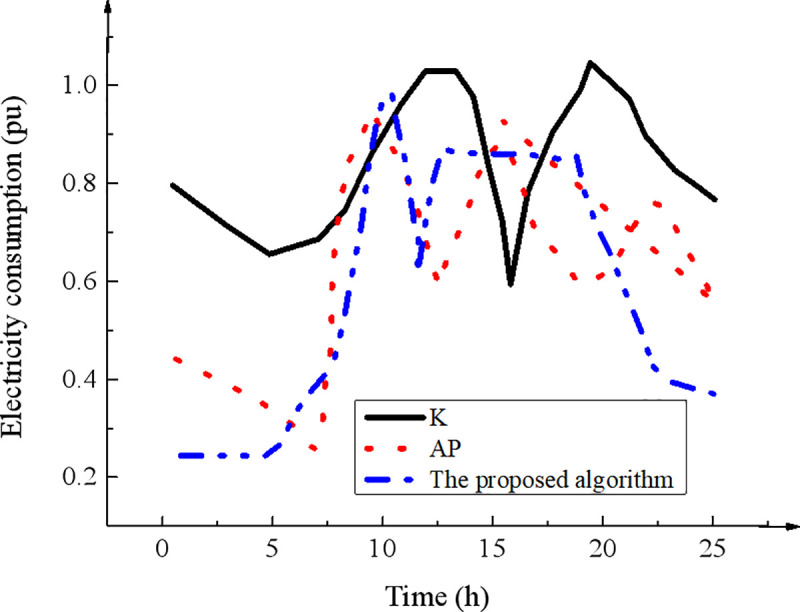
Clustering results of centralized clustering algorithms and proposed DCA.